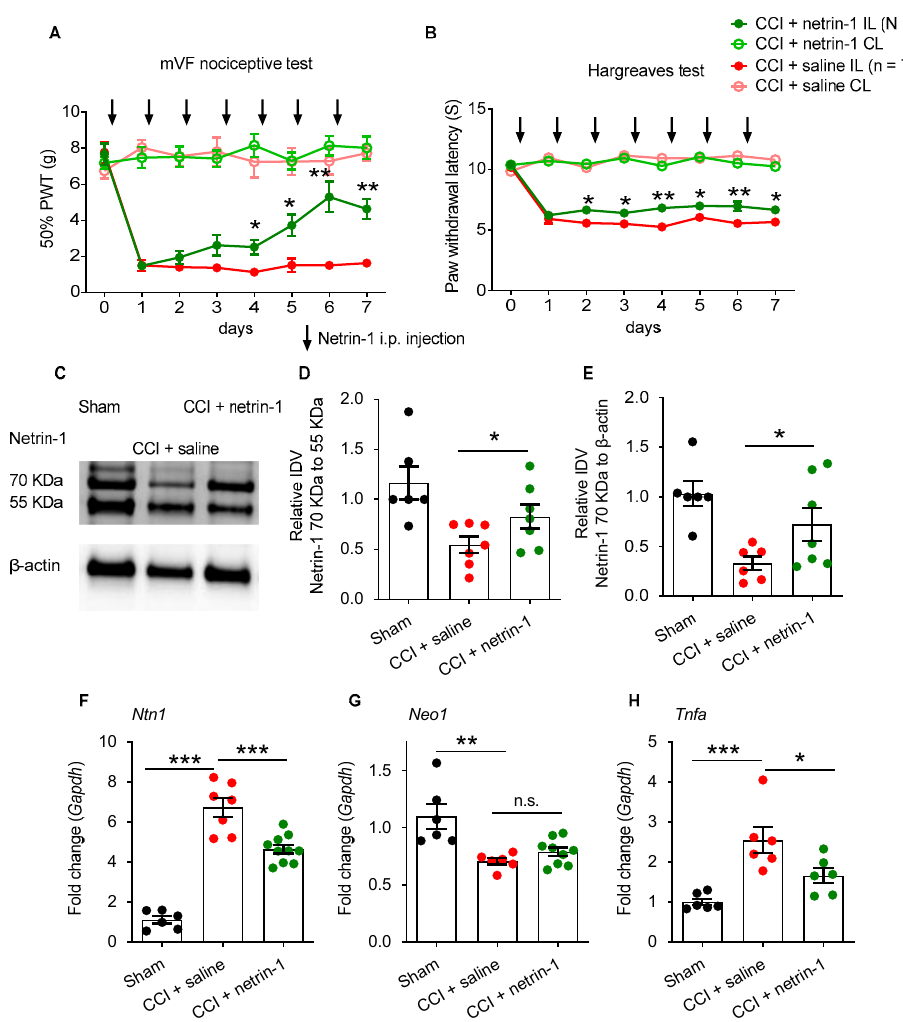
Figure 2. Systemic netrin-1 injection improves injury-induced hypersensitivity and restores netrin-1. Wistar rats with CCI injury were treated with recombinant human netrin-1 injections starting on the day of injury (i.p., 10 µ g/rat). Controls rats were treated with a solvent or underwent sham surgery. ( A ) Mechanical nociceptive thresholds (assayed by von Frey filaments) and ( B ) thermal nociceptive thresholds (assayed by the Hargreaves’ test) were measured over 7 d post-injury (two-way ANOVA with Bonferroni’s post hoc test comparing netrin-1 vs. saline, n = 7 or n = 9/group). The arrows indicate i.p. injection time points. ( C – E ) The fragment (55 kDa) and full length (70 kDa) bands of netrin-1 in the sciatic nerve were analyzed by Western blot and quantified by densitometry (IDV: integrated density value; CCI + saline versus CCI + netrin-1, Mann–Whitney U test). ( F – H ) Ntn1, Neo1, and Tnfa expression in the sciatic nerve (Mann–Whitney U test). (C-I) n = 6/group. All values were normalized to sham, mean ± SEM, * p < 0.05, ** p < 0.01, *** p < 0.001, n.s.: not significant.